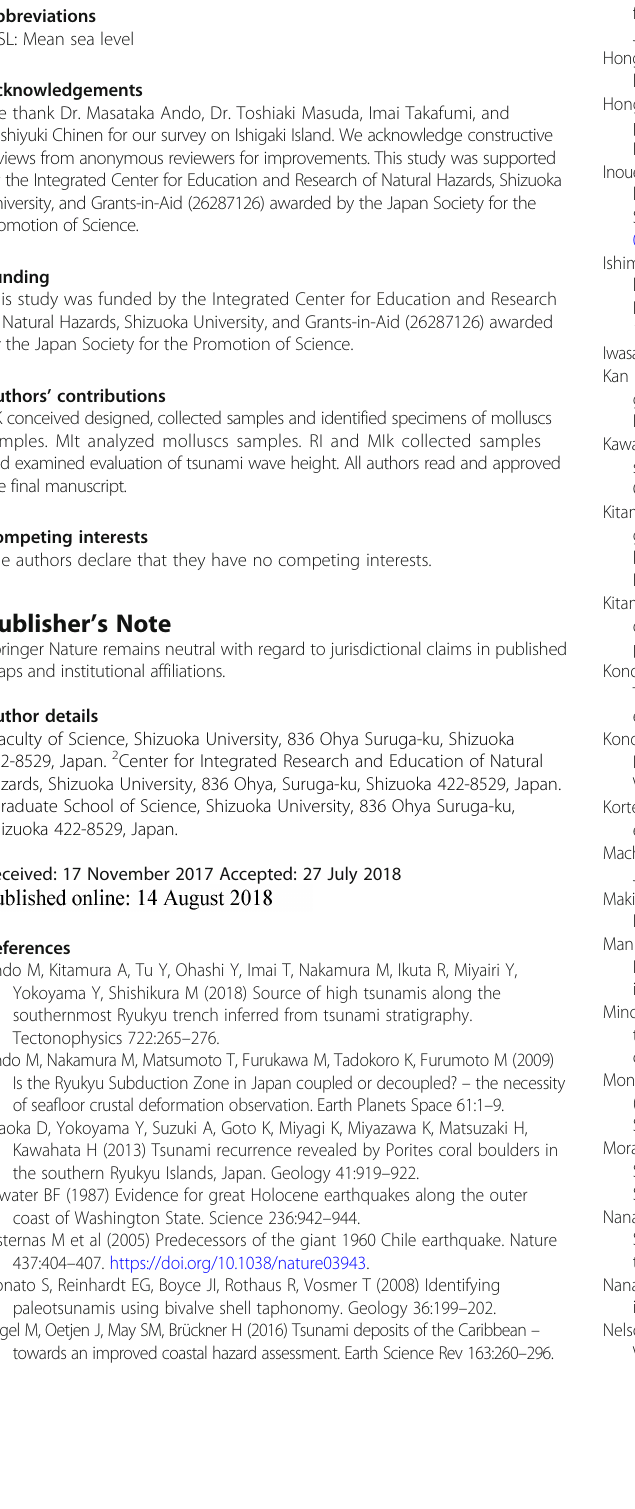
Additional file 3: Table S3. List of molluscan specimens collected from the tsunami deposits with method 1. (XLSX 19 kb) Additional file 4: Table S4. List of shell sizes and shell weights of specimens collected from the tsunami deposits with method 1. (XLSX 27 kb) Additional file 5 Table S5. List of molluscan specimens collected from the tsunami deposits with method 2. (XLSX 16 kb) Additional file 6 Table S6. List of shell sizes and shell weights of specimens collected from the tsunami deposits with method 2. (XLSX 30